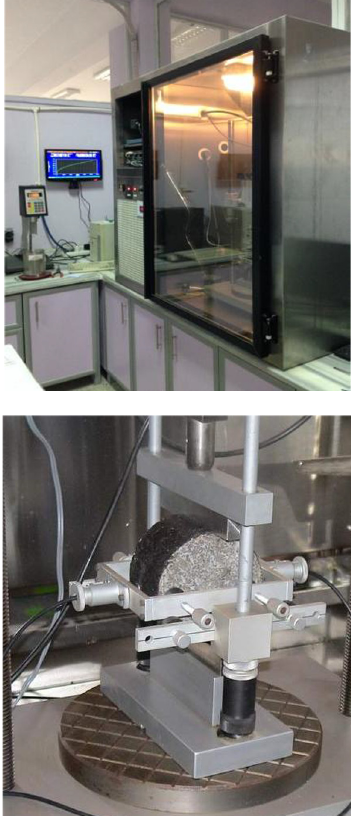
Fig. 2. The indirect tensile stiffness modulus test